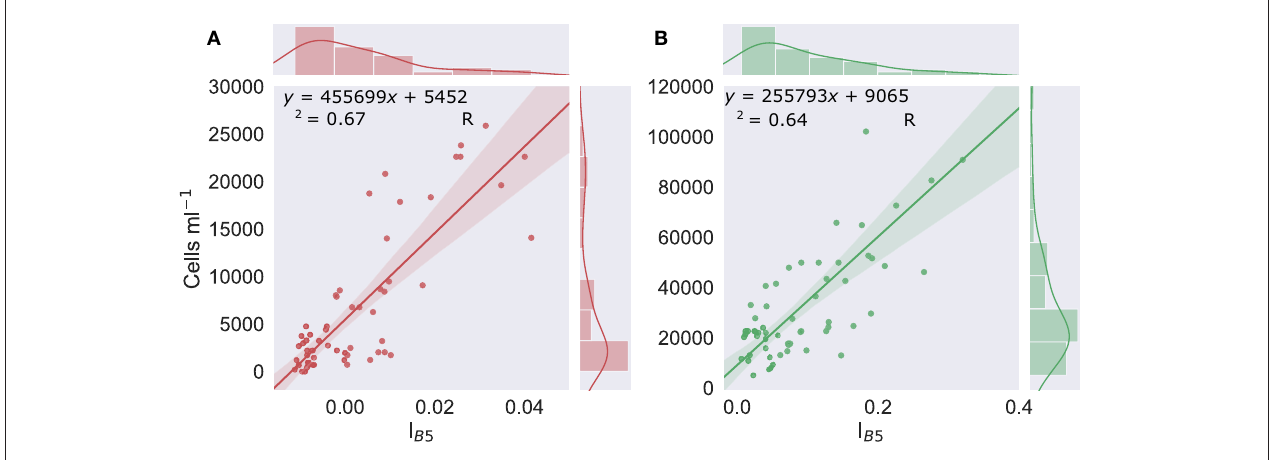
FIGURE 4 | Cell density vs. I B 5 . Linear regression of the scaled integral of WorldView 3’s Band 5 relative to Bands 4 and 6 (I B 5 ) (derived from resampled field HDRF), vs. concentrations of red (left, graph A ) ( n =57) or green (right, graph B ) (n=60) algal cells within the snow. Shaded area shows the 95% confidence interval. Marginal histograms show data